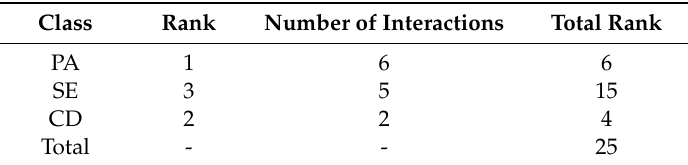
Table 9. Sample of FCS learners’ interactions ranking.